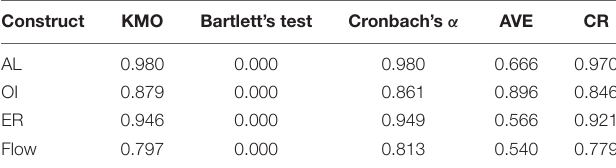
TABLE 2 | Validity and reliability of study